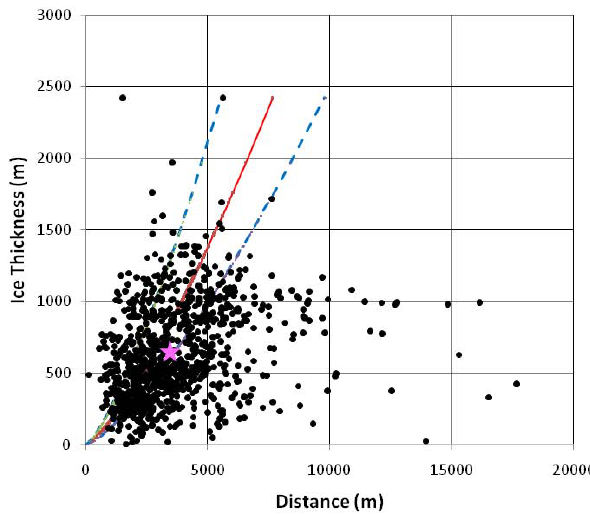
Fig. 13. Relationship of distance between ASAID grounded ice boundary and ASAID hydrostatic line to ice-equivalent thickness. Red line is theoretical relationship (Eq. 7) discussed in the text with blue dashed lines being one standard deviation from this theoretical relationship. Magenta star indicates the position occupied by the mean distance and mean ice thickness of all 930